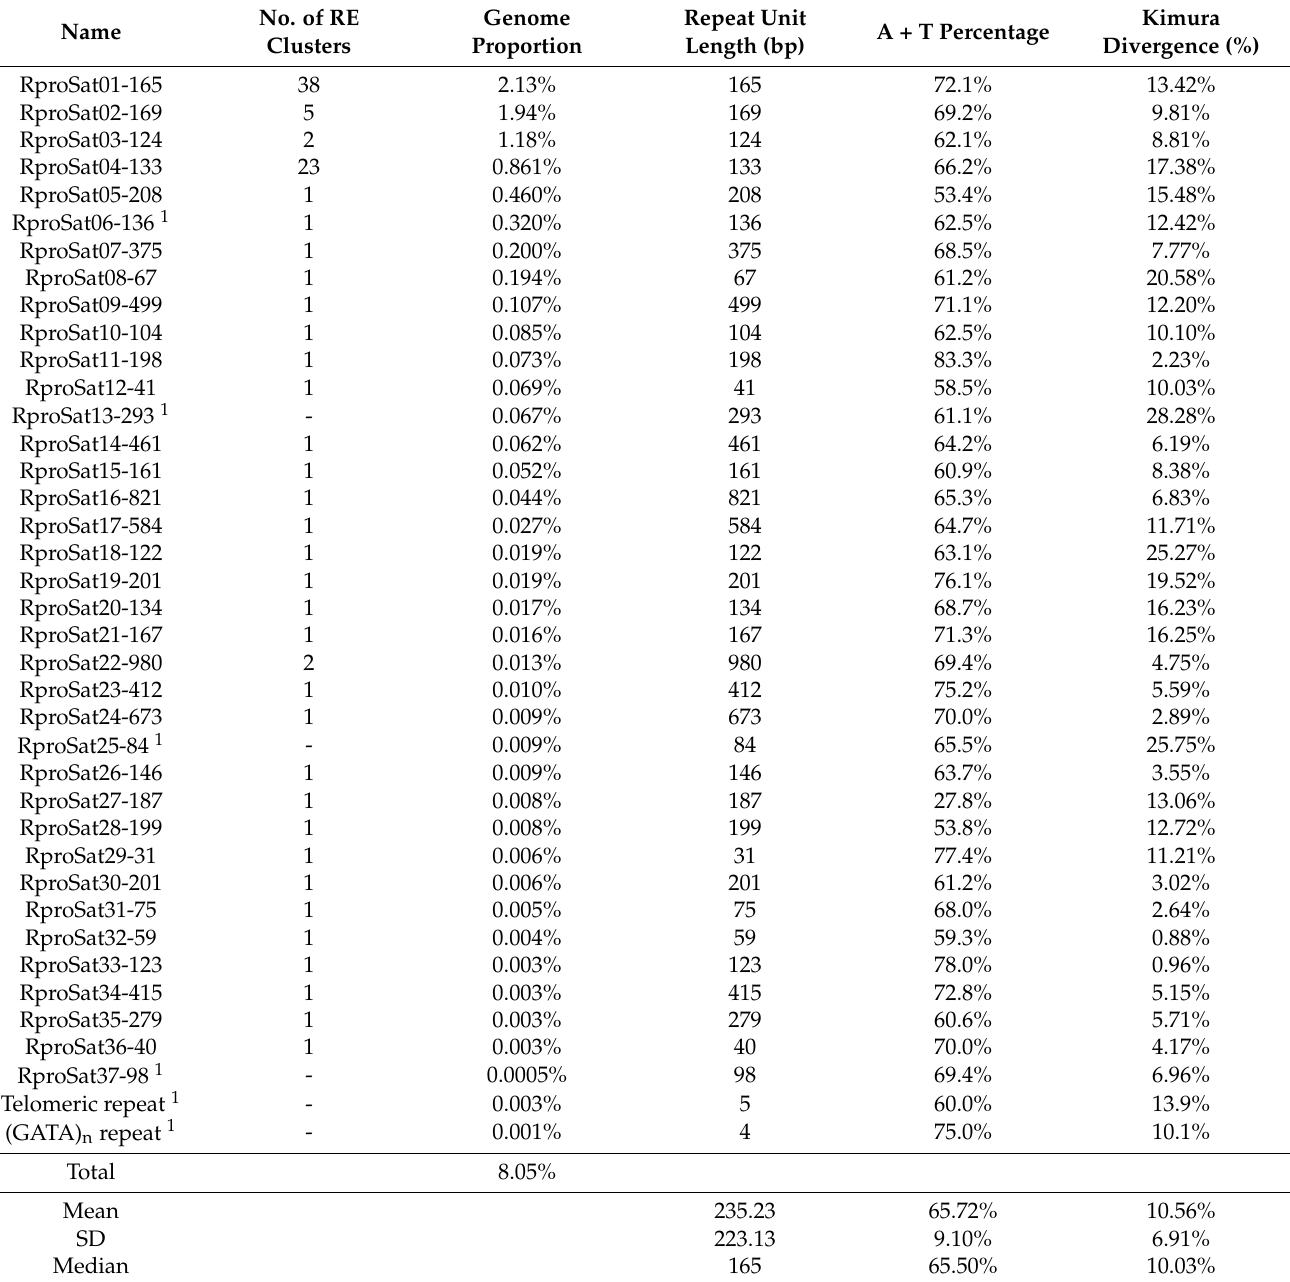
Table 1. Data of the satDNA families found in Rhodnius prolixus : genome abundance (%), length of the repeat unit, A + T content and divergence (%). The number of clusters in the RepeatExplorer2 analysis is also shown. GenBank